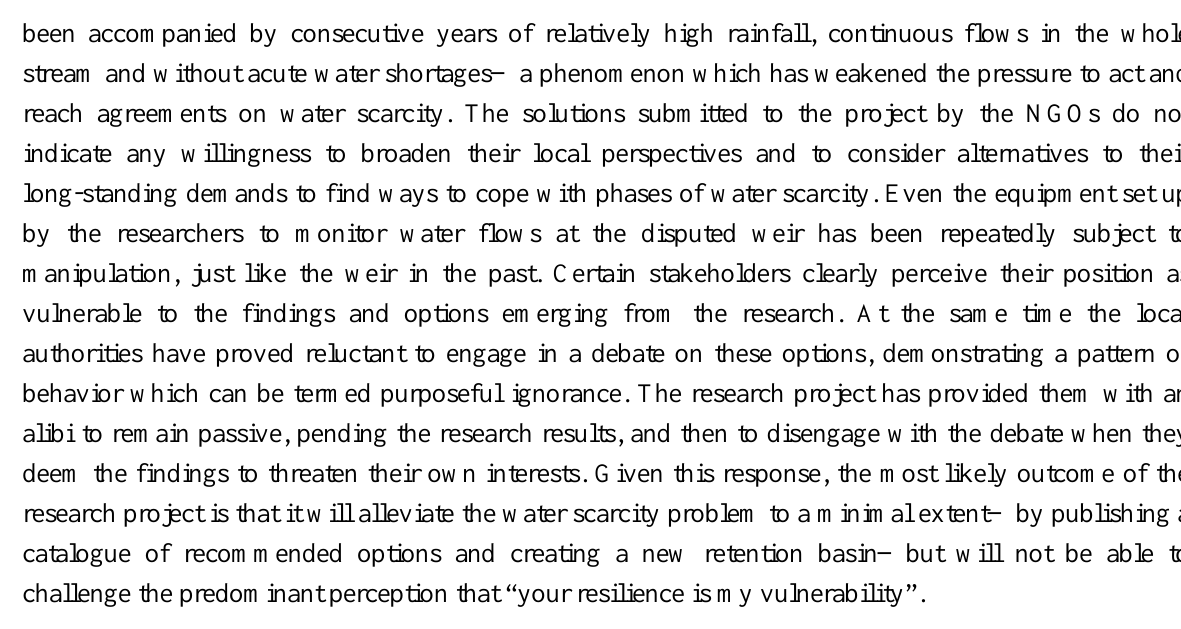
Figure 2. Resilience strategies of different groups of